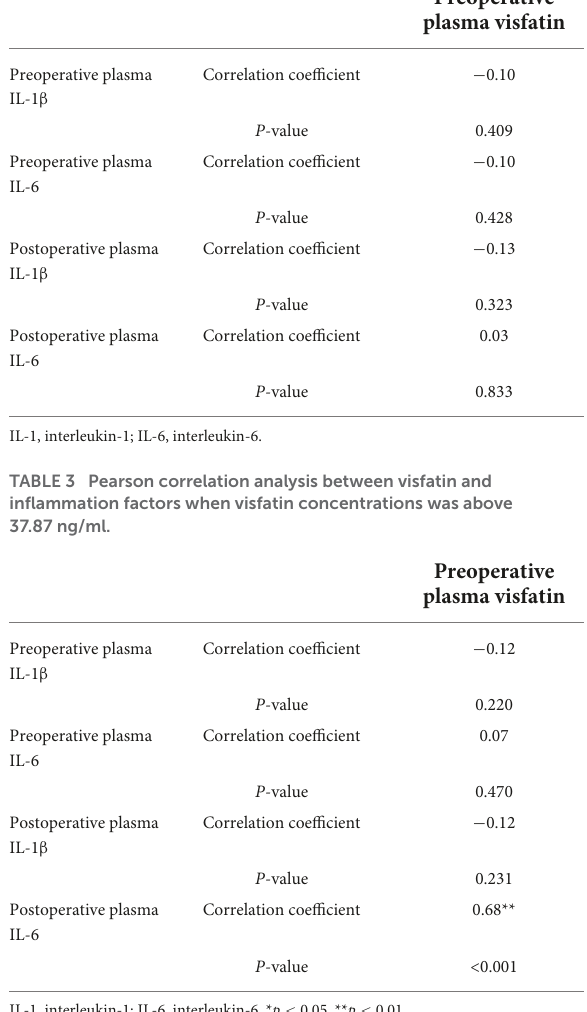
TABLE 2 Pearson correlation analysis between visfatin and inflammation factors when visfatin concentrations was lower than 37.87 ng/ml.